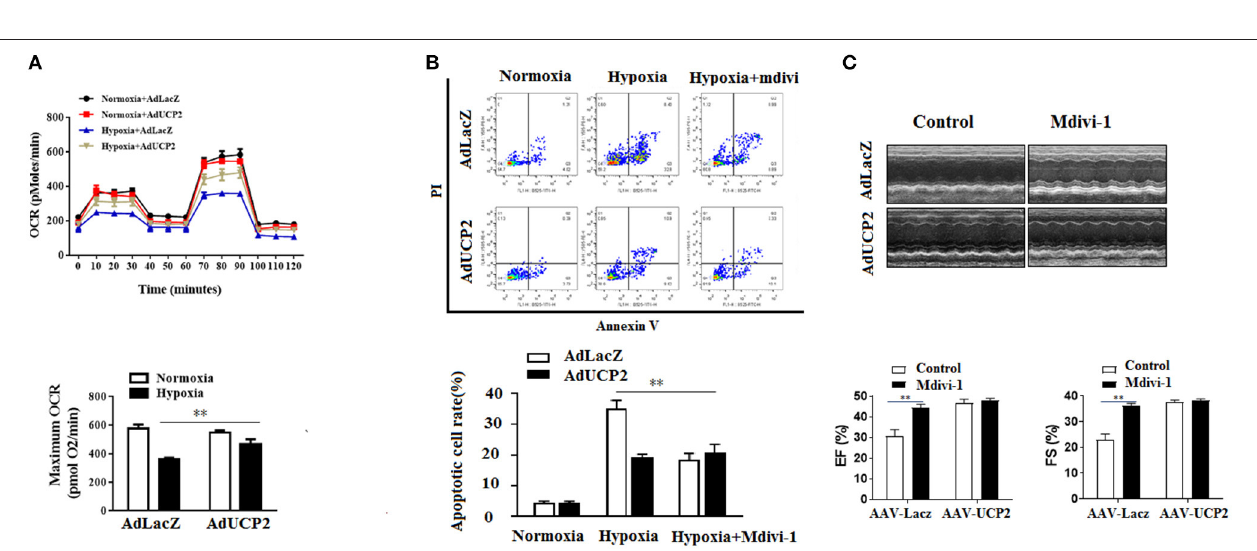
FIGURE 7 | UCP2 affects cardiomyocyte oxygen consumption rate (OCR) and apoptosis through DRP1. (A) Cardiomyocyte OCR was measured in different groups. (B) Cardiomyocyte apoptosis was detected using flow cytometry in different groups. (C) M-mode images of the left ventricle (LV) in different groups were measured after MI. Mdivi, an inhibitor of DRP1; ** P < 0.01 compared with each